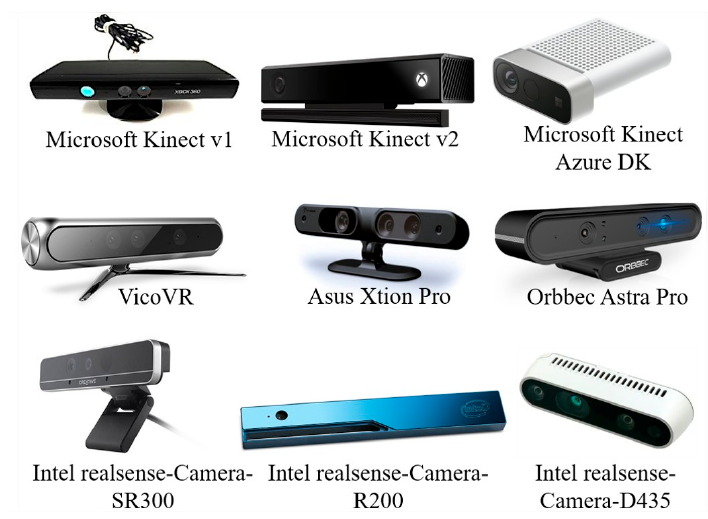
Figure A1. Recent RGB-D sensors: structured-light (Kinect v1, Asus Xtion Pro, Intel SR300), time-of-flight (Kinect v2, Kinect Azure DK, VicoVR), and active stereo vision (Intel R200, D435).